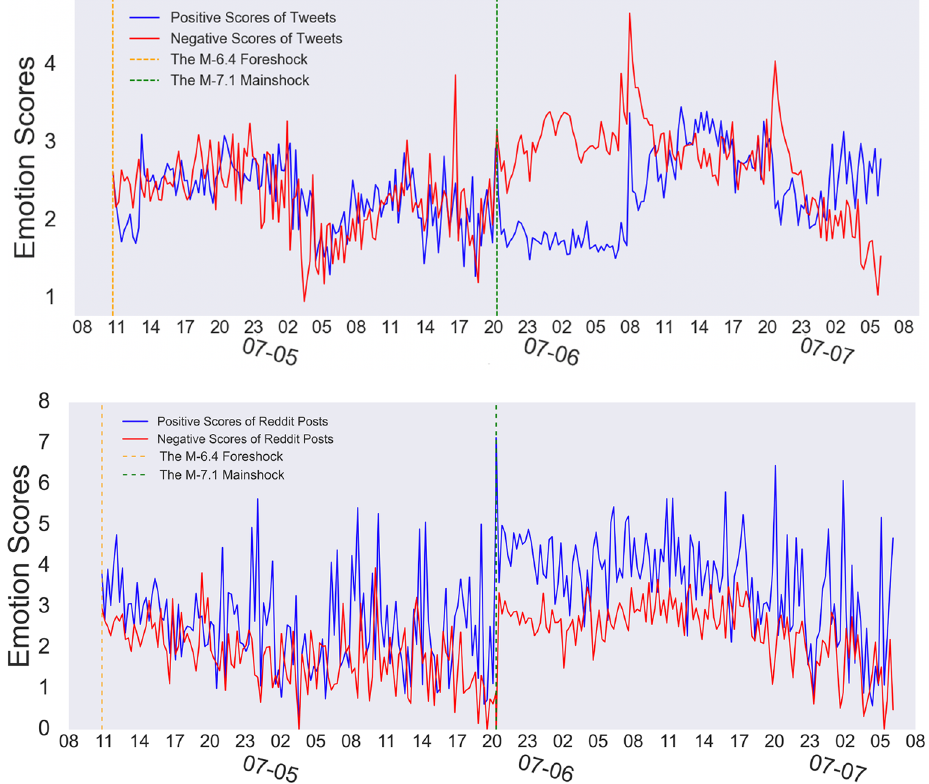
Figure 3. Emotion scores of people’s tweets and Reddit posts in every 15-min time window. The emotion scores in this plot are calculated based on the percentage of positive and negative emotion words within a text string, e.g., a positive score of 8 here means that on average, 8 percent of words in the documents during the 15 min are positive words.